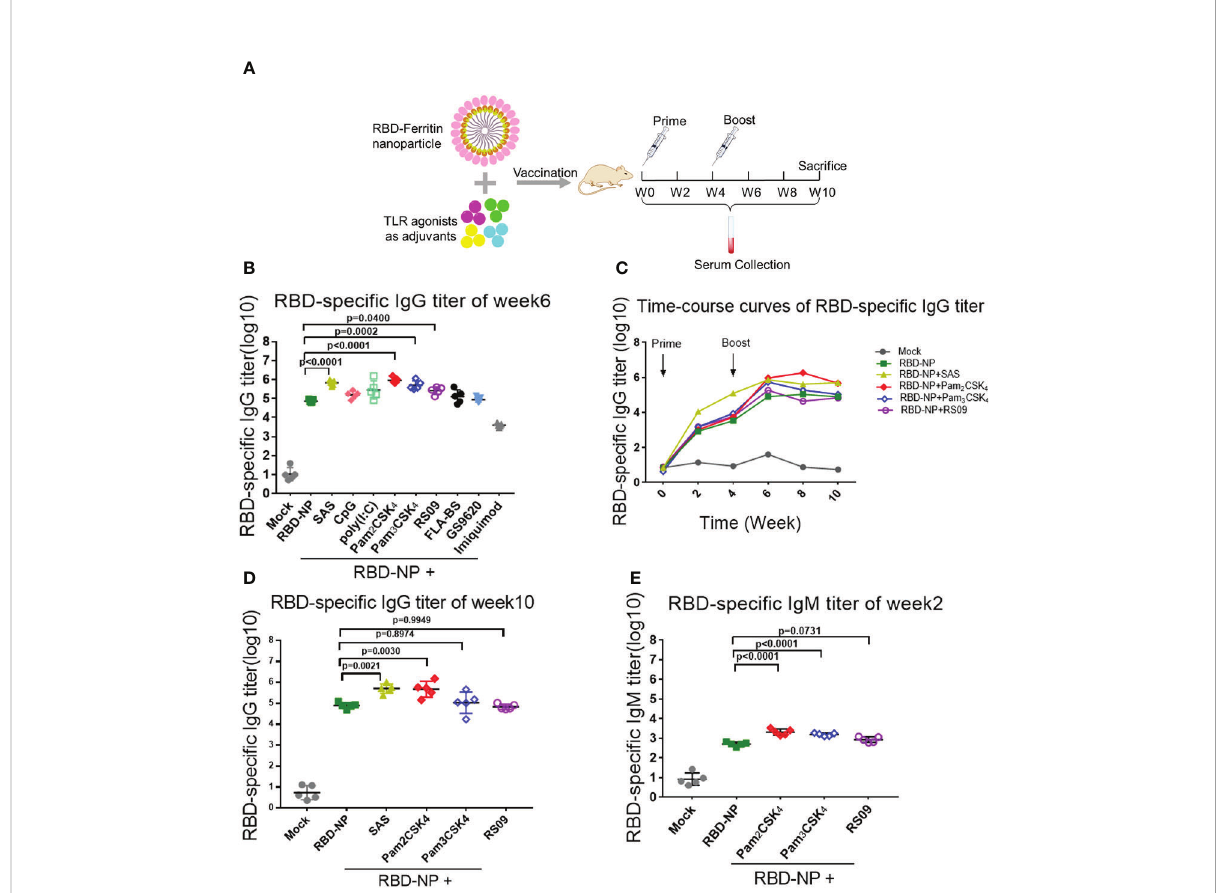
FIGURE 2 Screening of TLR agonist adjuvant to enhance humoral immune response elicited by SARS-CoV-2 nanoparticle vaccine. (A) Schematic design of BALB/c mice immunized with the Prime-Boost strategy. Sera were collected every two weeks after the initial immunization. (B – D) Monitor SARS-CoV-2 RBD-speci fi c IgG titers in immunized mice by ELISA from week 0 to week 10. IgG titers of sera were measured by serial dilution and represented as the reciprocal of the endpoint serum dilution (n = 5). B: IgG titers of sera at week 6; c: RBD-speci fi c IgG titers were calculated every two weeks and plotted as a time-course curve; D: IgG titers of sera at week 10. (E) RBD-speci fi c IgM titers of immunized mice were collected by ELISA at week 2 (n = 5). One-way ANOVA was used in Tukey ’ s multiple comparison test. Experimental data are expressed as Mean ±